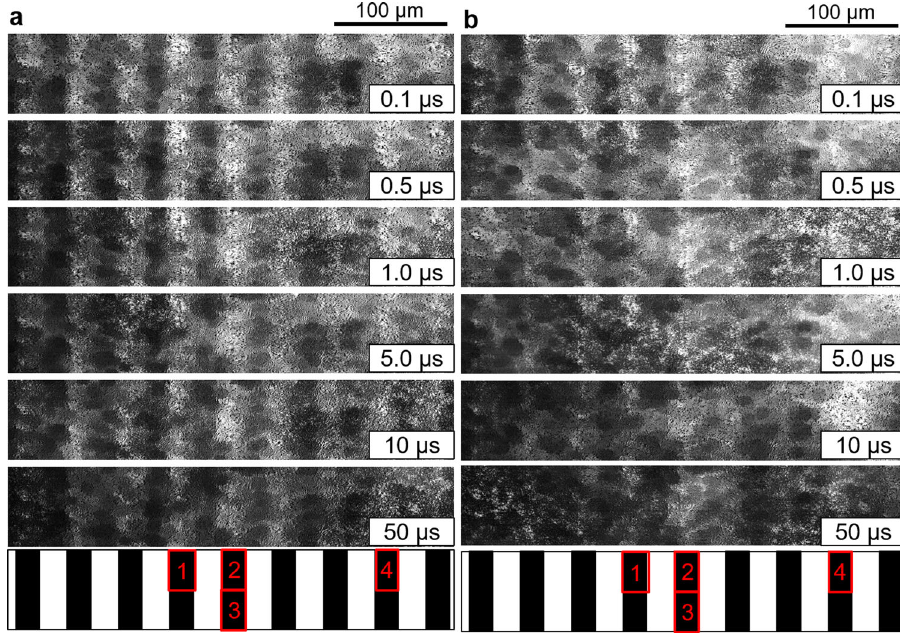
Fig. 1 The image sequences of the patterned-illumination time-resolved phase microscope (PI-PM) in different solvents. The images correspond to the refractive index changes after photo-excitation by a UV pump light for SrTiO 3 :Rh/ITO/BiVO 4 :Mo (STOR/ITO/BVOM) Z-scheme water-splitting sheet measured by the PI-PM method ( a in ACN, b in water). The light intensity patterns of the pump light are shown at the bottom of each image sequence, and the selected regions for the cluster analysis are indicated in red squares. The result of the cluster analysis for area No. 1 is shown in Figs. 4 – 6, and the others are presented in Supplementary Figs. 4 –